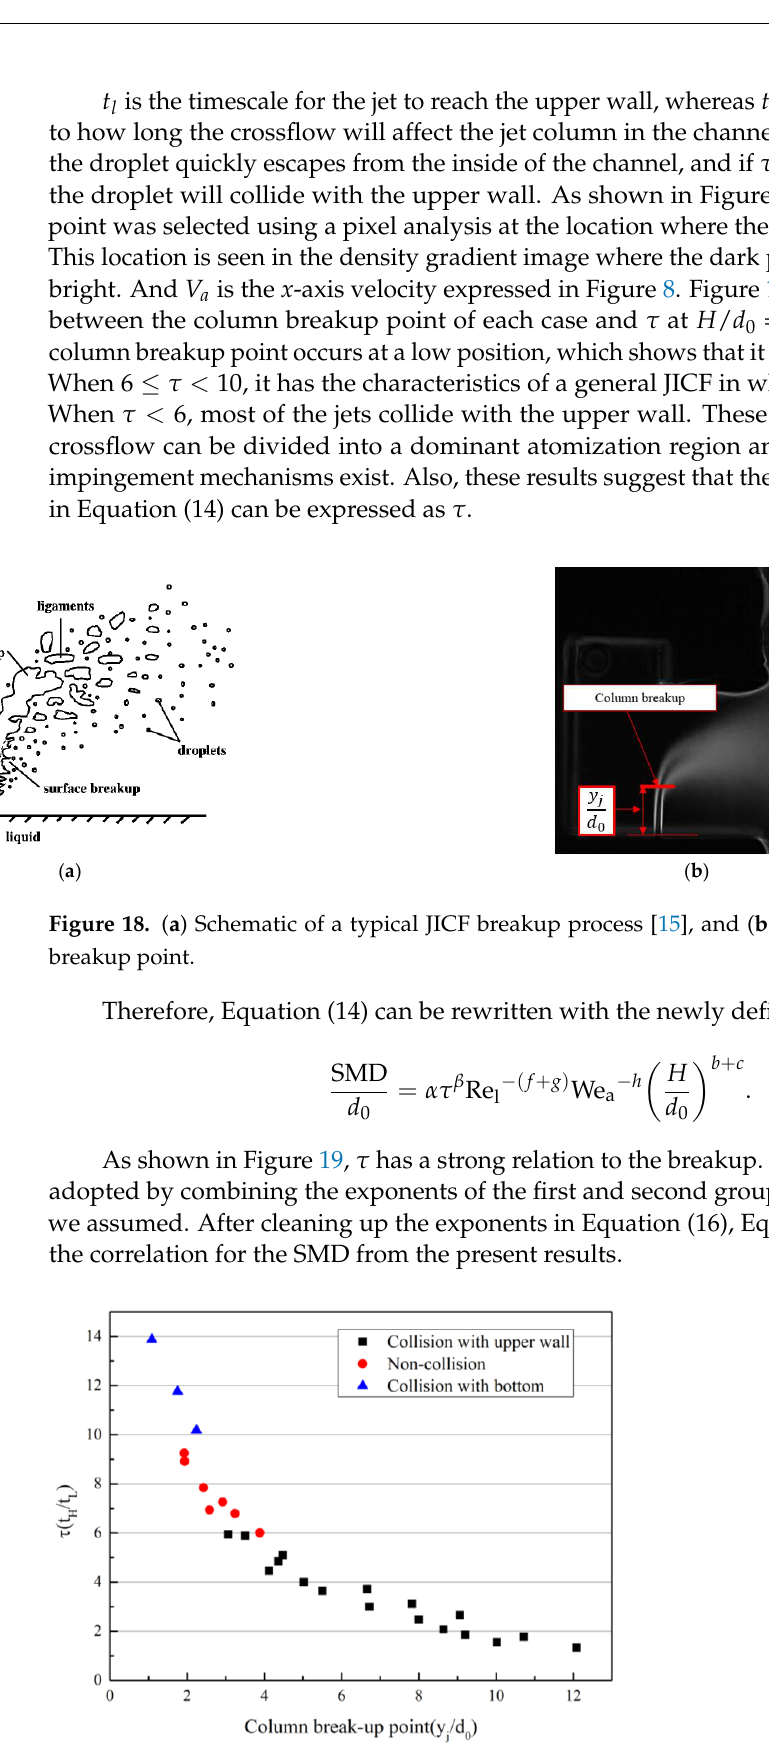
Figure 19. Relationship between τ and breakup point when H / d 0 = 20.